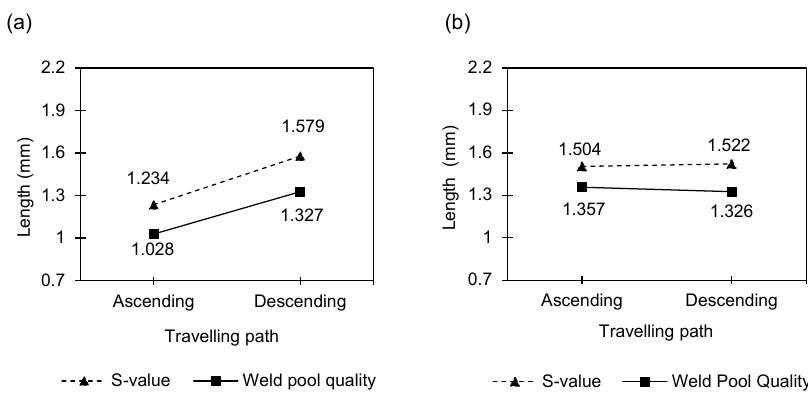
Figure 5. Main effect plots of the average s ‐ value and weld pool quality in terms of the travelling path for experiment ( a ) #1 ‐ 1 (laser power: 1.6, 1.8, and 2 kW, part ‐ to ‐ part gap: 0.3 mm) and ( b ) #1 ‐ 2 (laser power: 4, 5, and 6 kW, part ‐ to ‐ part gap: 0.3 mm). Table 8. ANOVA table for experiment #1 ‐ 1 (2 ‐ kW fiber laser welding system).